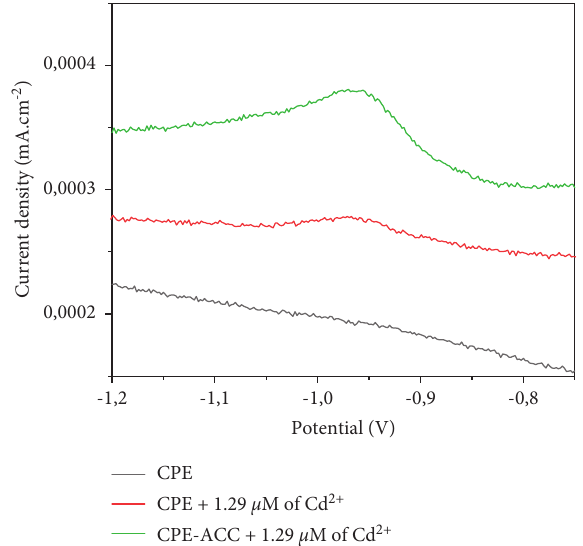
Figure 4: Sensibility of electrodes with Cd 2+ by